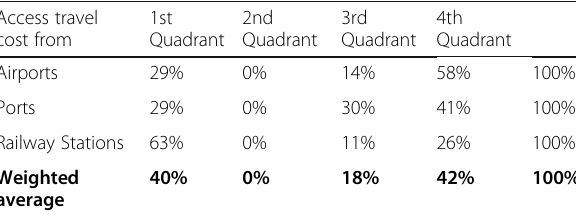
Table 6 percentage distribution of the considered tourist sites by quadrants in the AG-diagram Access travel cost